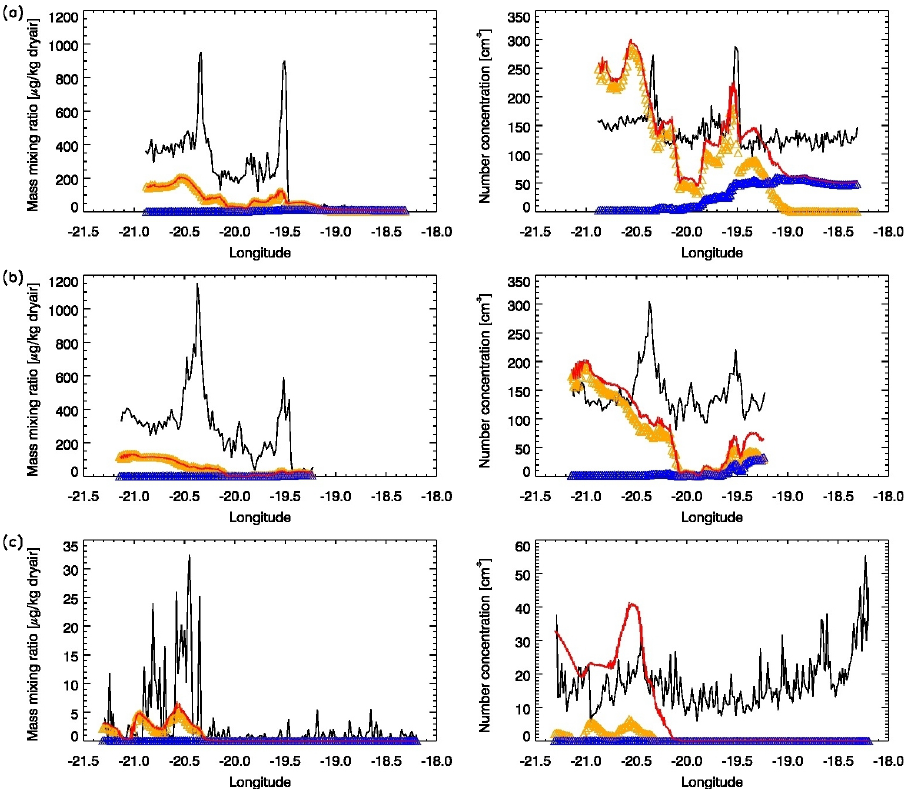
Fig. 12. As in Fig. 10 but for particle mass mixing ratio [µgkg − 1 ] (panels on the left) and particle number concentration [cm − 3 ] (panels on the right). The black line correspond to 10 second averages of aircraft measurements from PCASP. The red line shows the sum of all simulated aerosol types (i.e. dust, sea salt, black carbon, organic carbon, ammonium, nitrate and sulfate). Orange triangles show simulated dust and blue triangles simulated sea salt. Model results are only shown for diameters between 0.133µm and 4.05µm to allow comparison to the PCASP